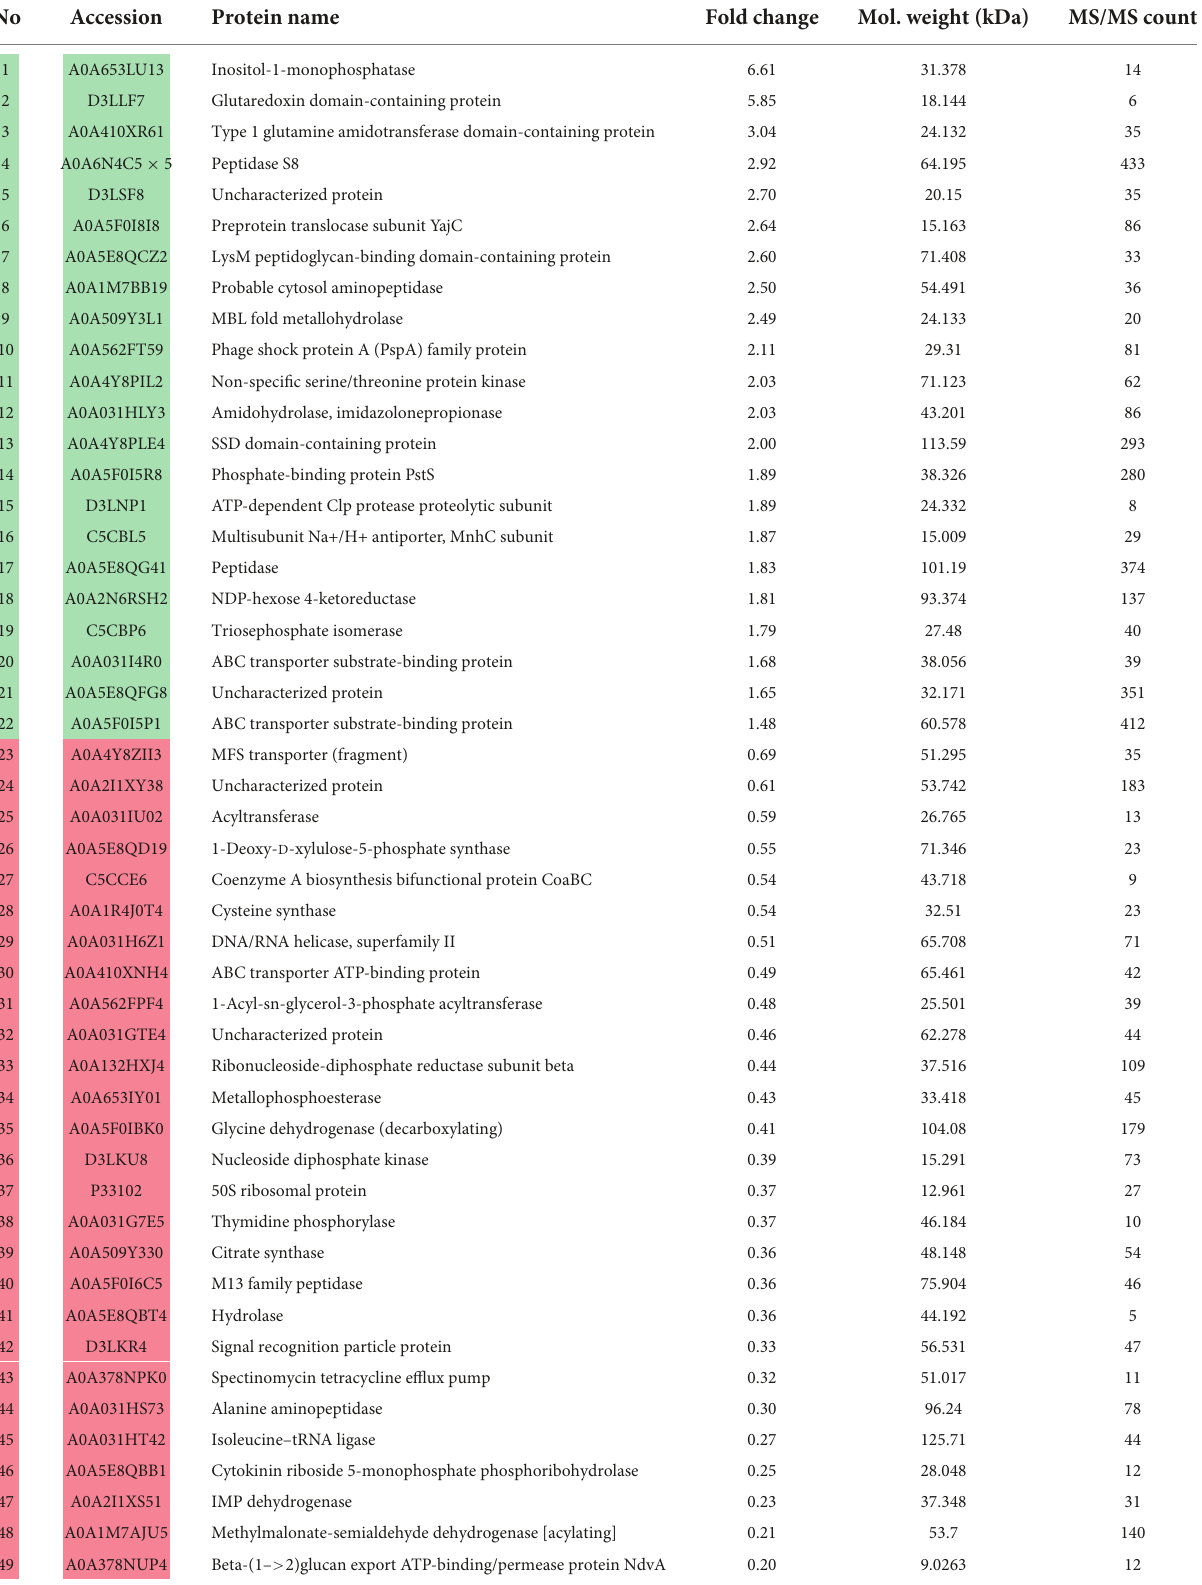
TABLE 2 Changes in M. luteus C01 biofilm matrix protein concentrations in the presence of 4.9 × 10 − 9 M epinephrine after 24 h of incubation in comparison with